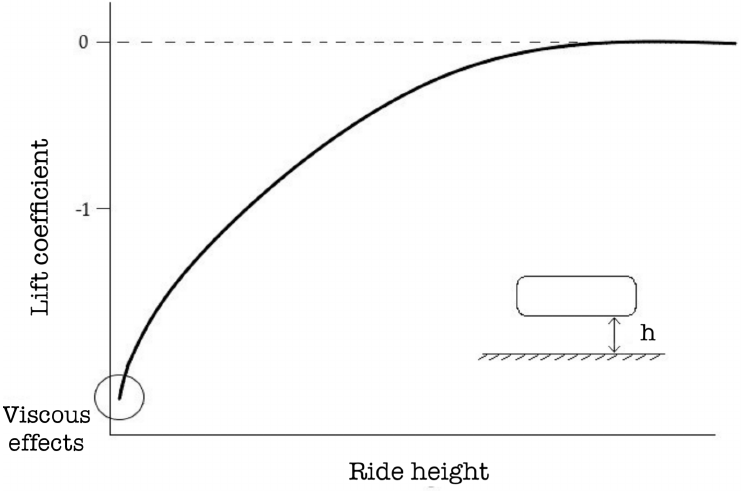
Figure 4. Downforce generation at different ride heights